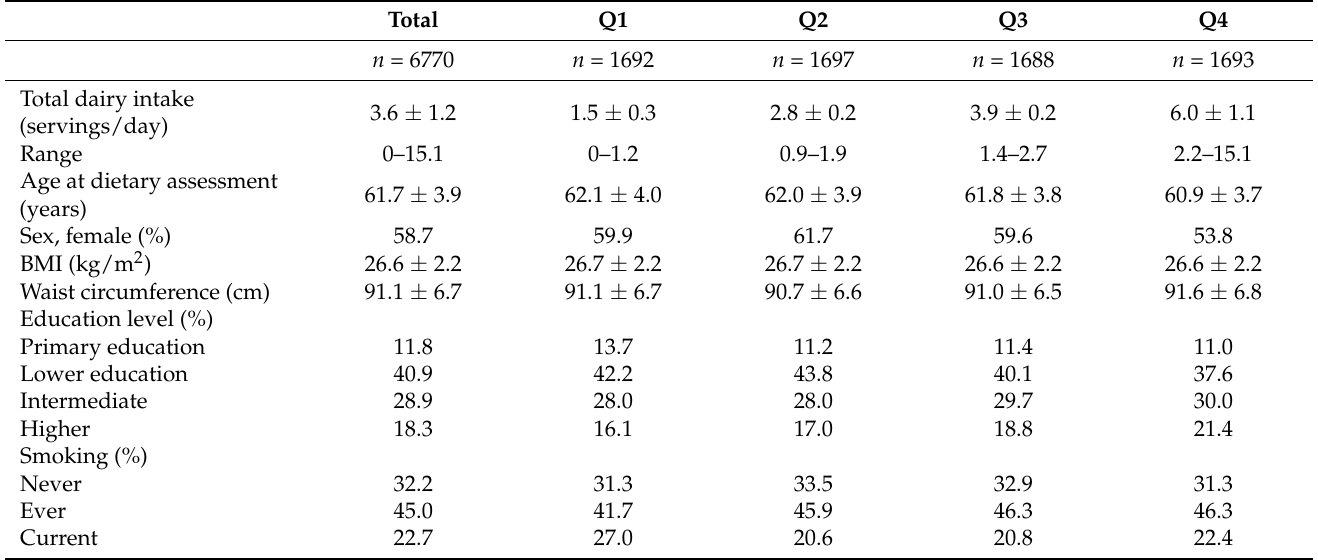
Figure 1. Dairy-type intake by cohort of the Rotterdam Studies in servings/day (mean ± SD): milk, 200 mL; yogurt, 150 mL; cheese, 20 g; cream 3 g; ice cream, 50 g. Combined total dairy category: liquid dairy products, 200 mL; cheese, 20 g. RS, Rotterdam Study. Table 1. Baseline characteristics of study population ( n = 6770) according to quartiles of total dairy intake.